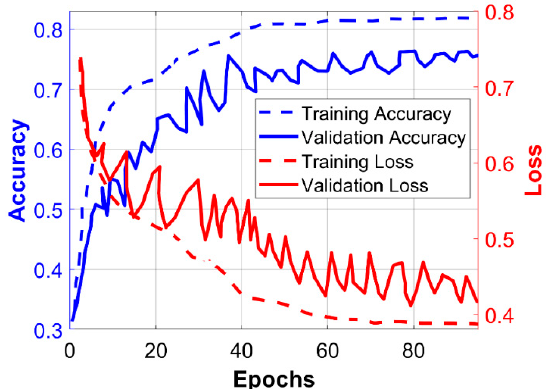
Figure 6. Training and validation curves of accuracy and loss of the CNN model with the softmax classifier. The x -axis denotes the training epochs.